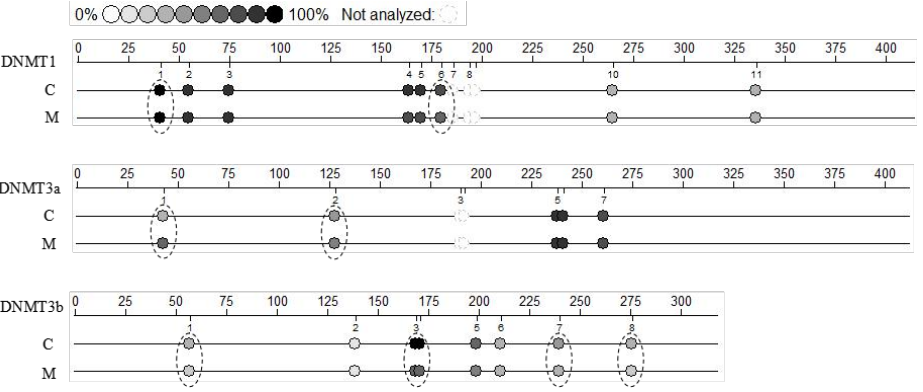
Figure 6. Methylation sequencing in cumulus cells; the experiment was repeated three times; loci within a circle differed ( p < 0.05).